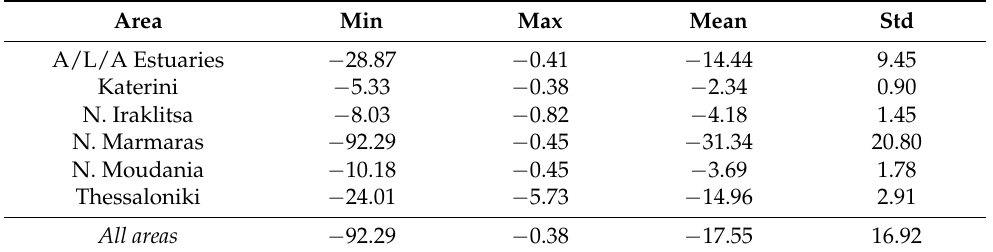
Table 2. Statistical results of the depth values obtained from in situ measurements for the six test areas